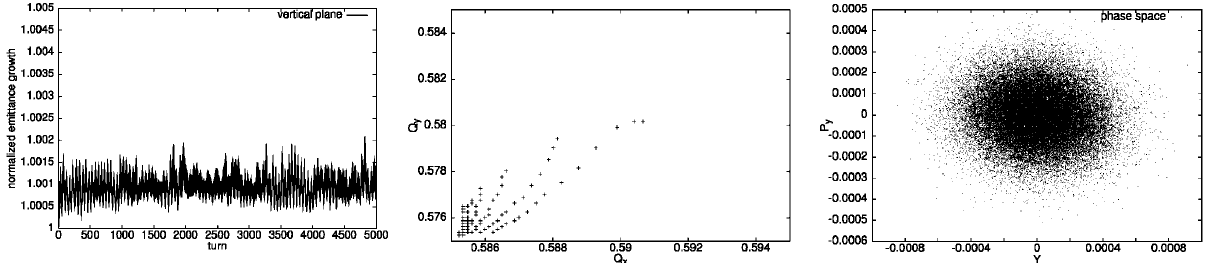
FIG. 2. The vertical normalized emittance growth of the weak beam (left panel), the tune spread of the weak beam with initial maximum 5 (cid:22) amplitude range (middle panel), and the vertical phase space distribution after 1000 turns (right panel), with an initial 20% mismatch of the strong beam and on-axis